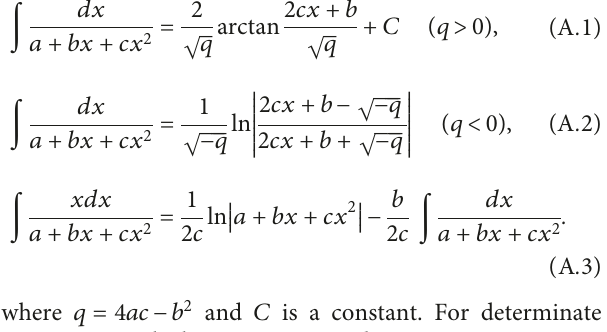
Figure 17: Performance points and target displacements in ADRS